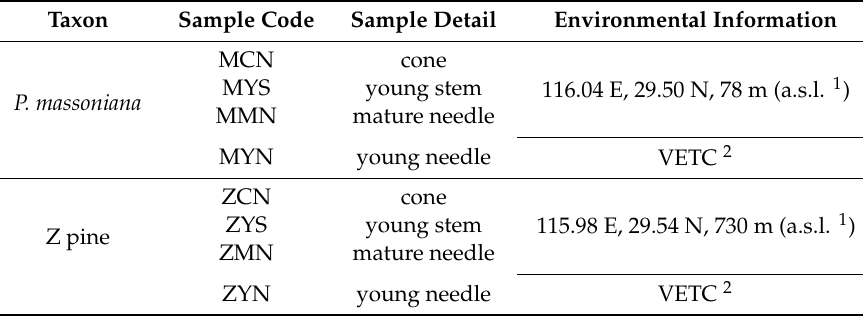
Table 1. Details of sample